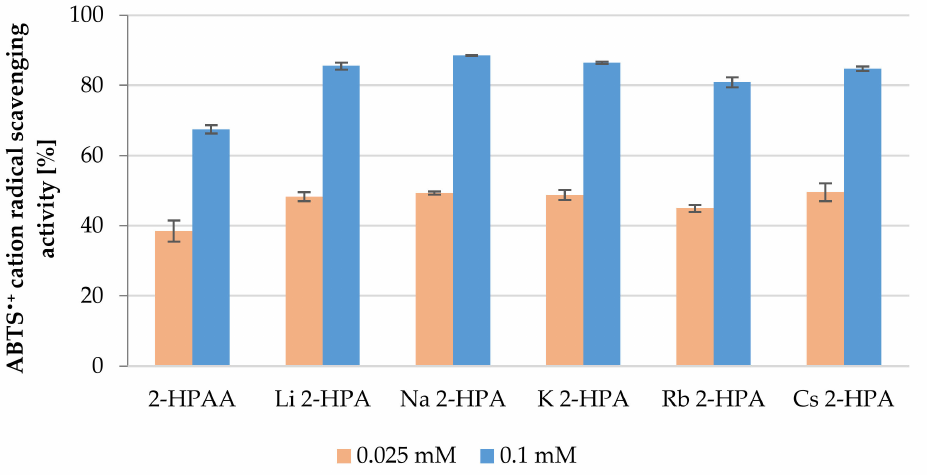
Figure 7. Antioxidant properties of the 2-HPAA and its alkali metal salts expressed as percentage of ABTS • + cation radicals inhibition (concentrations of tested substances in the samples 0.025 and 0.01